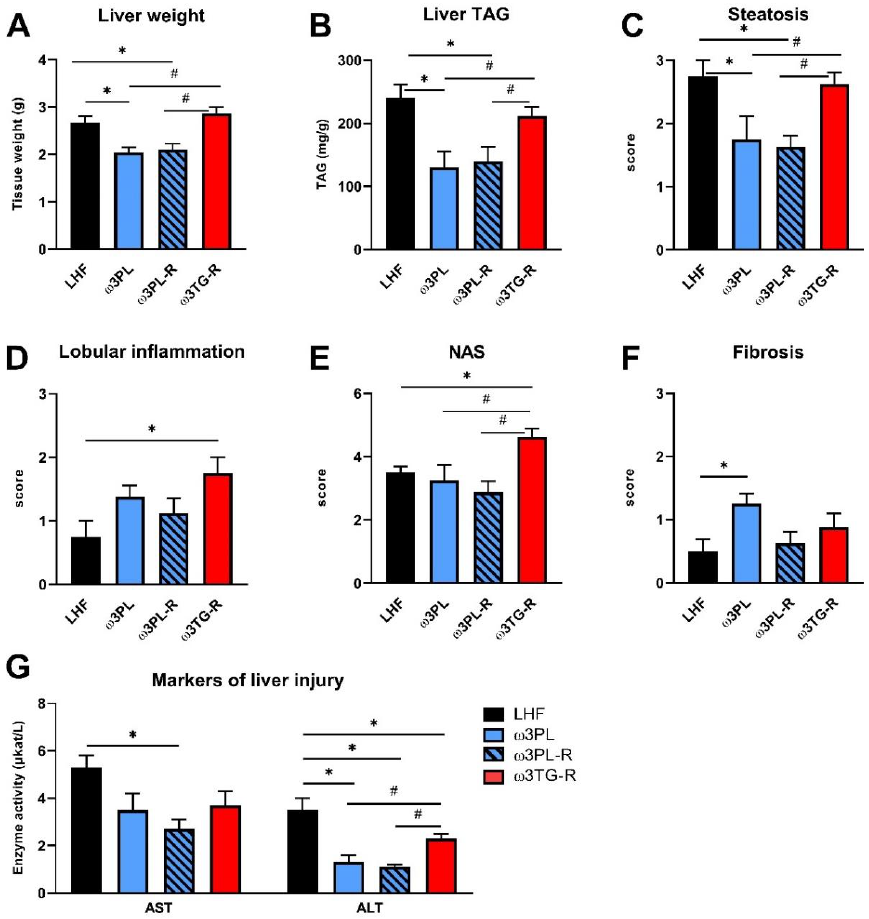
Figure 4. The effect of omega-3 PUFA supplementation on NAFLD-related parameters: liver weight ( A ), liver TAG content ( B ), steatosis ( C ), lobular inflammation ( D ), NAFLD activity score—NAS ( E ), fibrosis ( F ), and plasma AST and ALT levels ( G ). The results presented in panels C–F are based on histological analysis of liver sections. Data are means ± SEM ( n = 7–8). *, significant effect of omega-3 PUFAs (vs. LHF); #, significant difference from ω3TG-R (one-way ANOVA or Kruskal– Wallis).